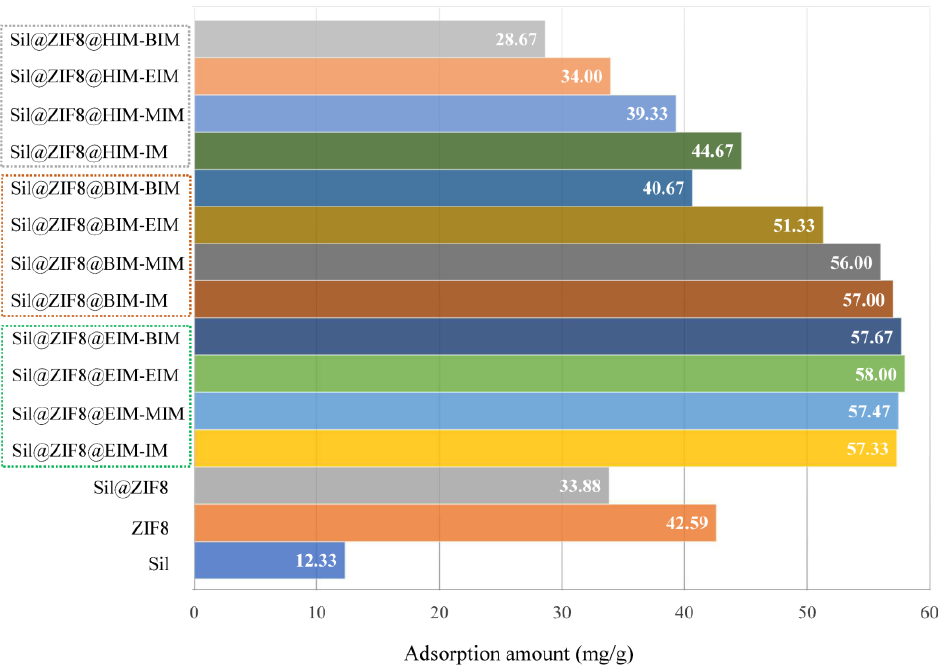
Figure 3. The maximum adsorption amounts of Sil, ZIF8, Sil@ZIF8 and 12 ILs-immobilized sorbents.